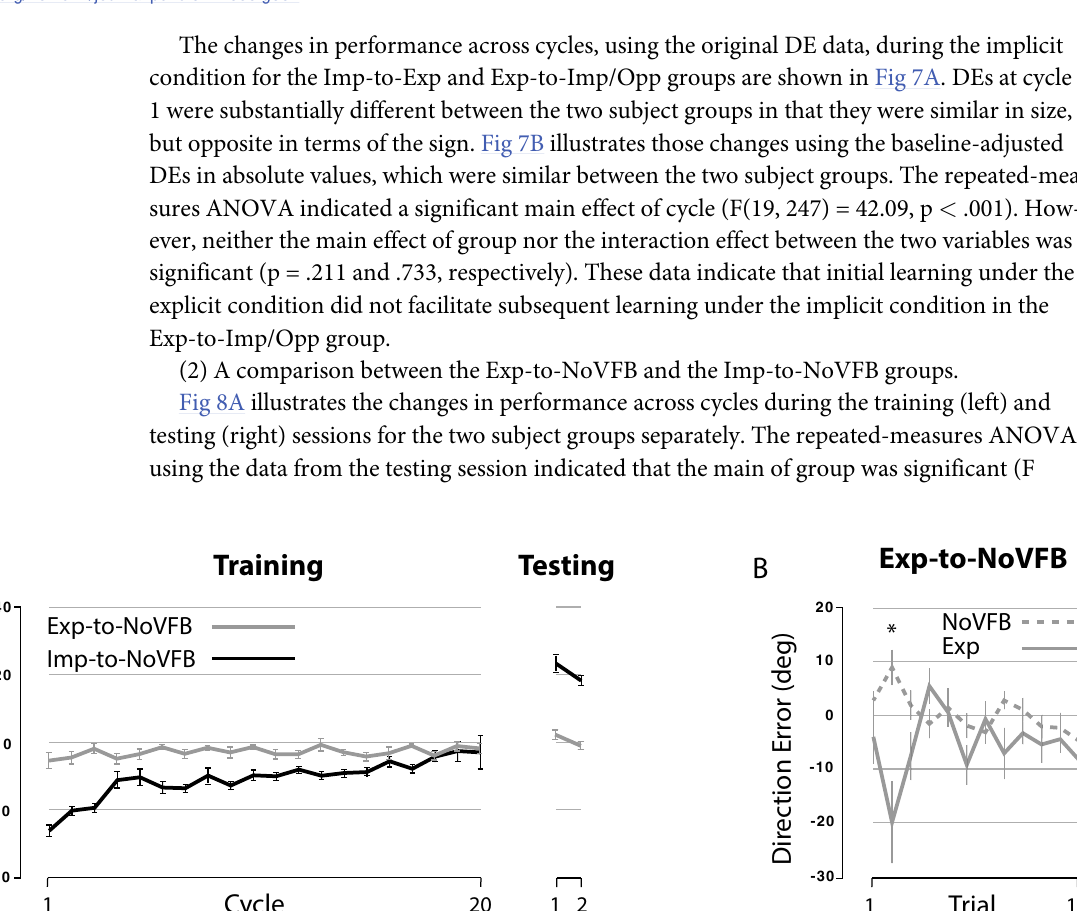
Fig 7. Changes in performance across cycles in Exp-to-Imp/Opp and Imp-to-Exp groups. (A) Each data point represents mean DE across six consecutive trials (cycle). Performance changes across cycles for Exp-to-Imp/Opp and Imp-to-Exp groups are shown separately. (B) Each data point represents baseline-adjusted DE in absolute values across six consecutive trials (cycle). � indicates significant difference, p < .05.